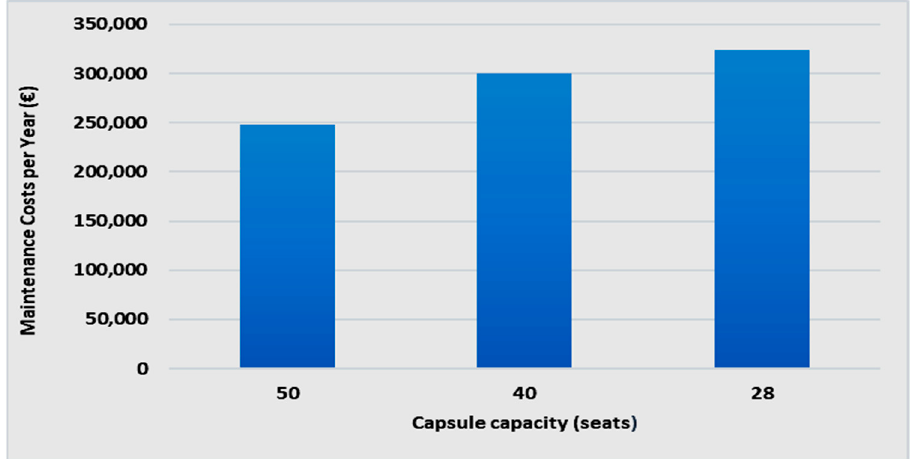
Figure 8. Maintenance costs per year under alternative capsule capacities.